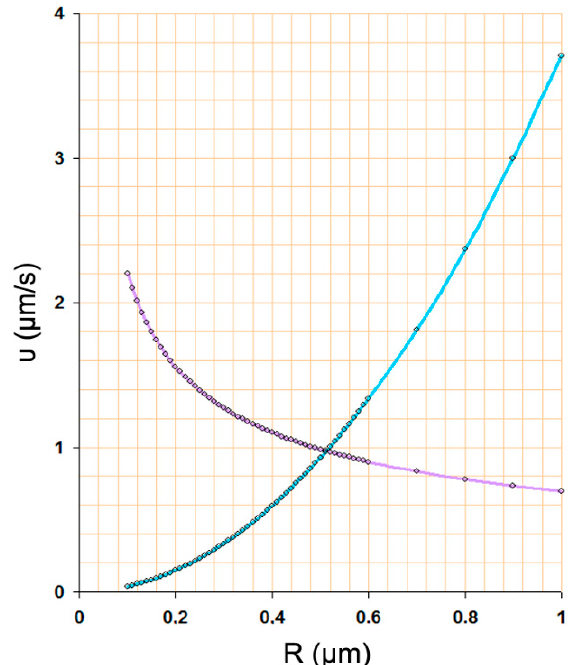
Figure 7. Buoyancy rise (cyan line) versus Brownian diffusion (purple line) for bubbles of different sizes. Cross-over point at R = 500 nm and υ = 1 μ m/s.